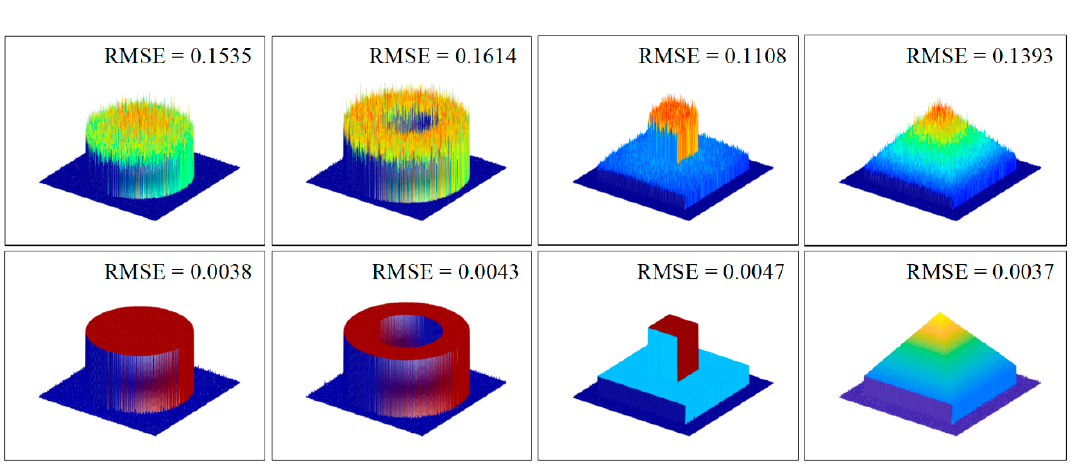
Figure 7. Numerical reconstructions: GS algorithm ( top ) and WCIA ( bottom ).